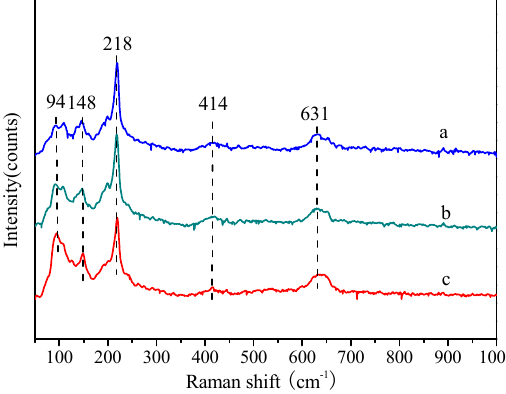
Figure 3. Raman spectra of ( a ) Cu 2 O ‐ NO 3 , ( b ) Cu 2 O ‐ Cl(1), and ( c ) Cu 2 O ‐ Cl(2).